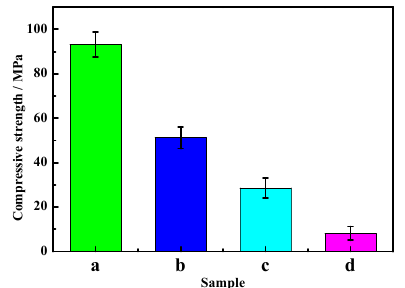
Figure 7. Compressive strength of the MOC samples after different dry–wet cycles: (a) without dry–wet cycles; (b) one time; (c) two times; (d) three times.